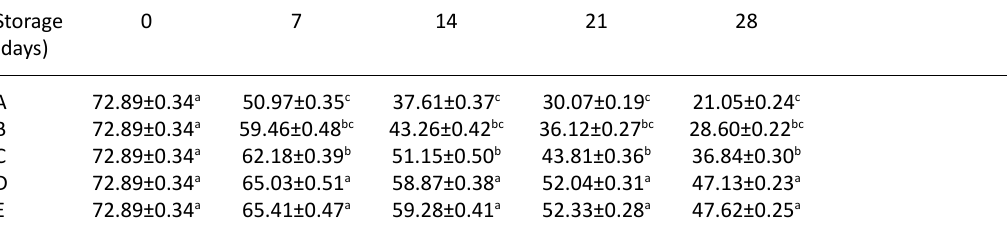
Table 2. Firmness (N) of mango fruit pre-coated by different MC-Car solutions during storage